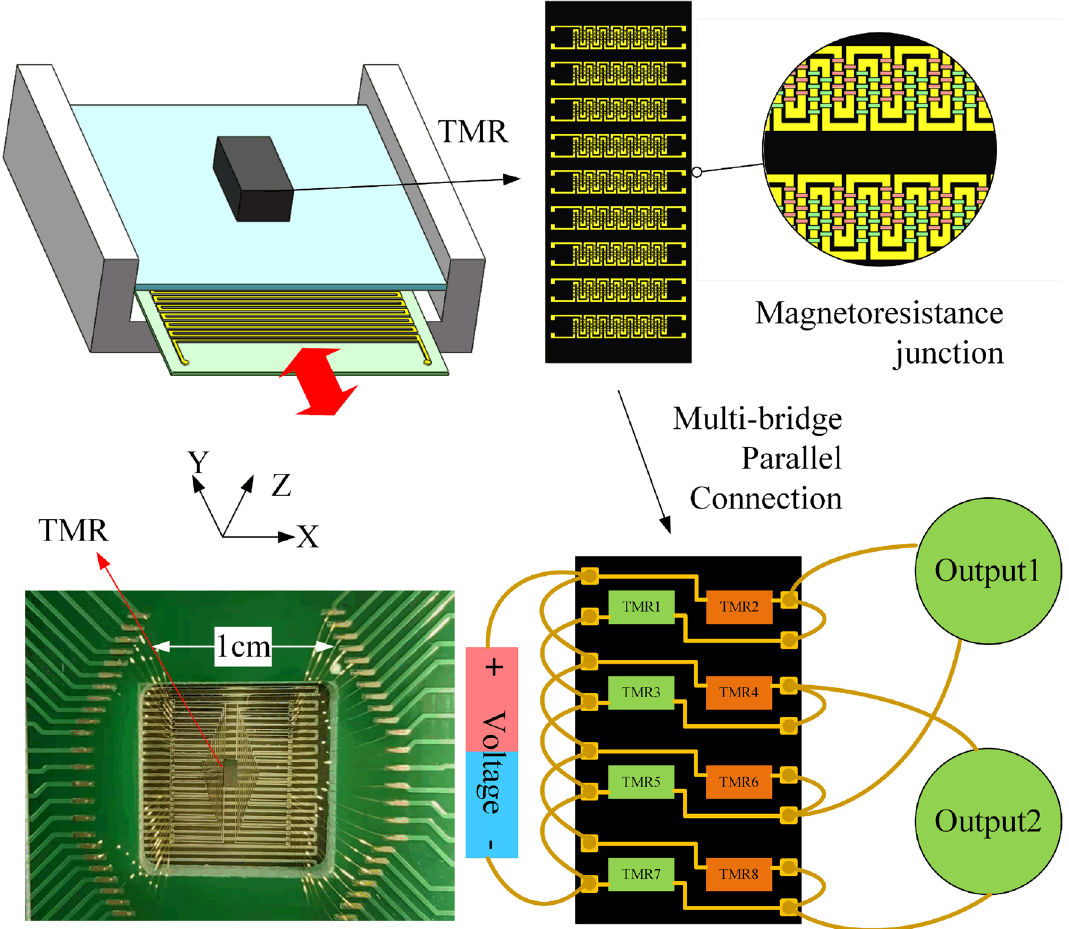
Figure 1. Schematic diagram of the TMR-based displacement sensor (Created by Microsoft Visio 2013 (15.0) and SOLIDWORKS(R) Premium